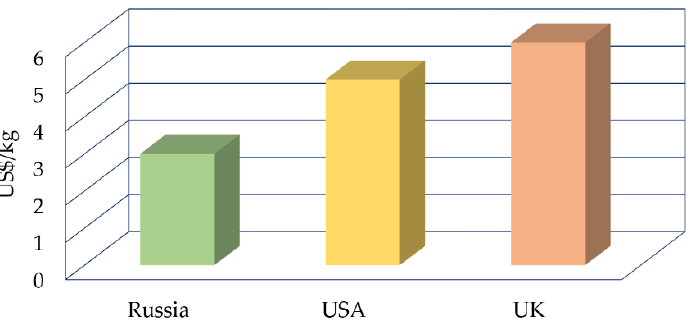
Figure 3. Hydrogen cost forecast for end user by 2025, USD per kg. Data from [22].